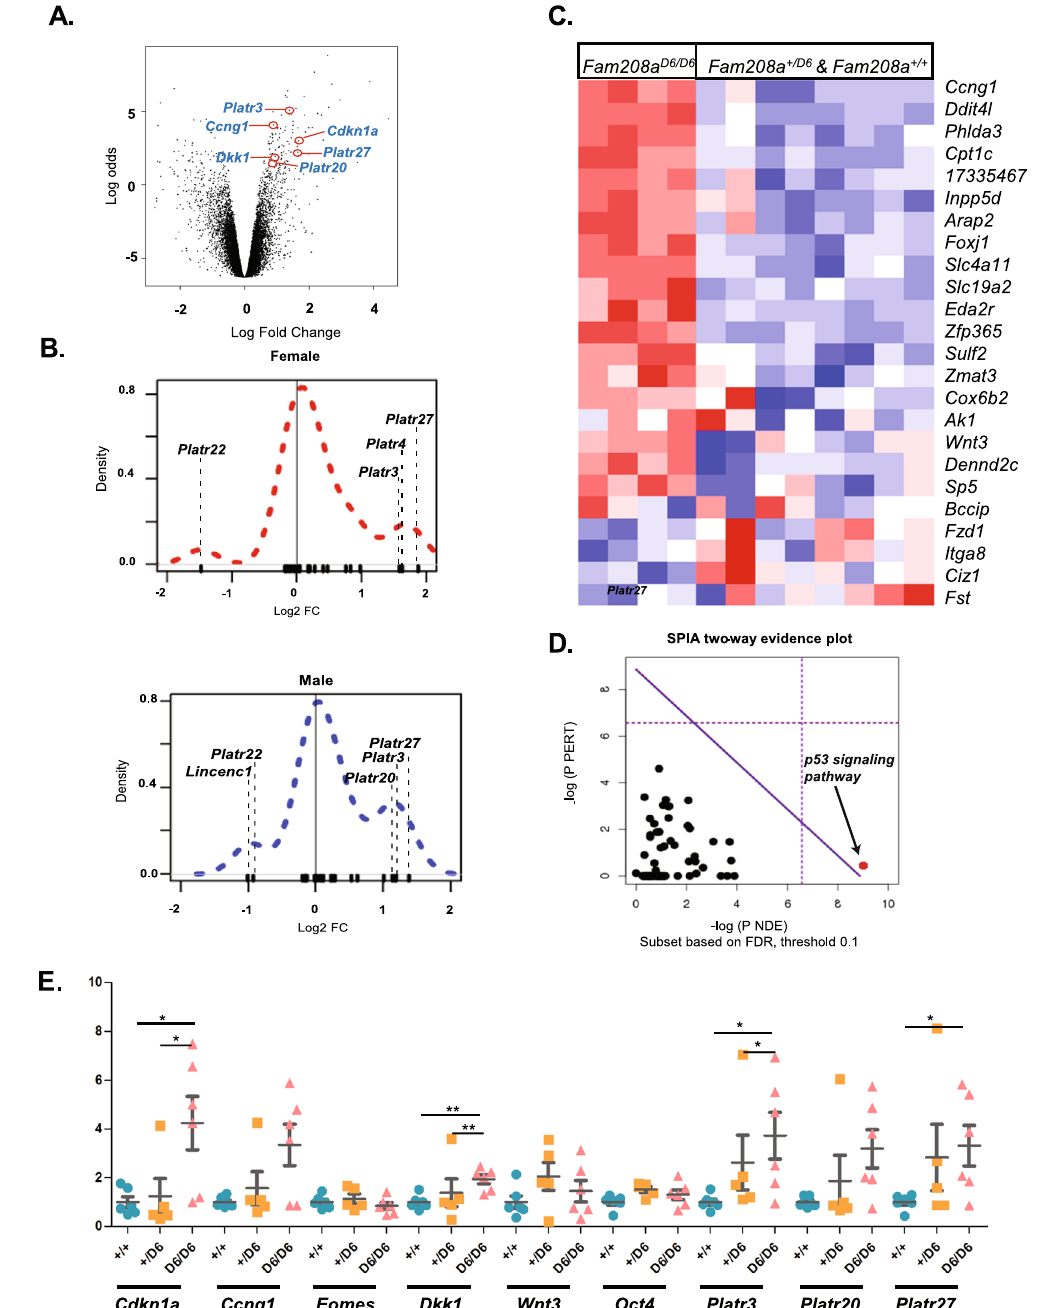
Figure 7. Increased p53 signaling and deregulation of pluripotency-associated transcripts in Fam208a D6/D6 epiblasts. ( A ) Volcano plot of Fam208a D6/D6 contrast with Fam208a + / + indicating position of selected genes selected for validation by qPCR. ( B ) density plots showing position of Platr genes in all genes differentially expressed between Fam208a D6/D6 and Fam208a + / + epiblasts with data segregated according to sex ( n = 2 each) ( C ) heat map showing differential expression of a p53 -bound, p53/p73 -regulated gene set defined by [7] ( D ) statistical overrepresentation of the p53 signaling pathway using SPIA analysis ( E ) single epiblast qPCR verification at E6.25 for gene expression normalized to Gapdh with mutant values represented as a fold change relative to wildtype littermate (average expression converted to 1). Expression measurements were carried out in duplicates per embryo (number of embryos; + / + , n = 6; + /D6, n = 4, D6/D6, n = 6). All results are calculated as mean ± SEM from at least two different